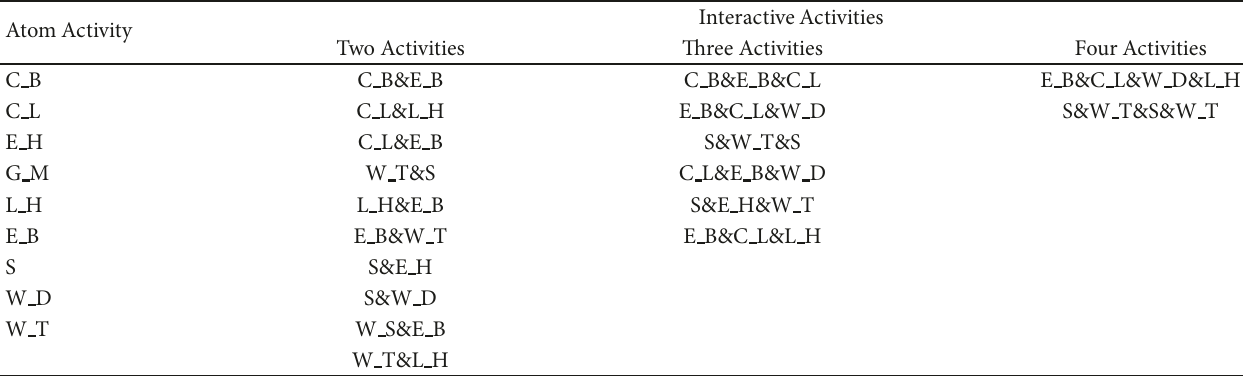
Table 2: Involved activities concerning on “tulum2009”.